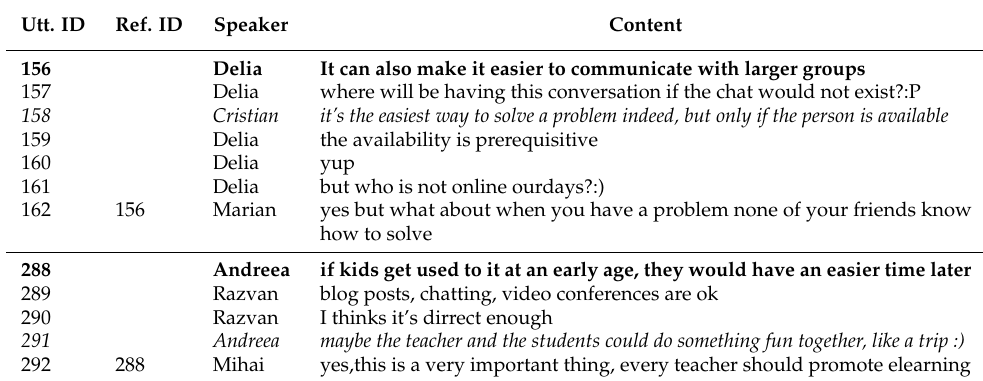
Table 10. First example of wrong semantic link prediction ( explicit link / predicted link ).